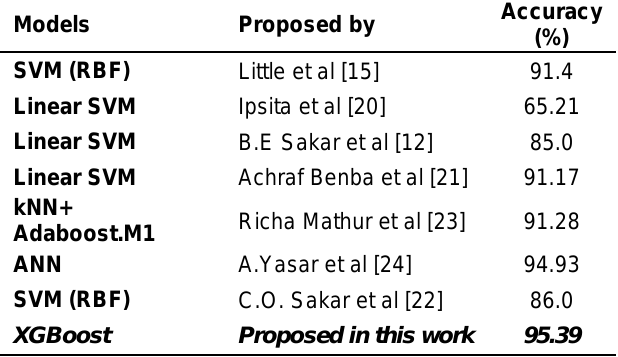
Table 4. Comparative Analysis of various models for Parkinson’s disease